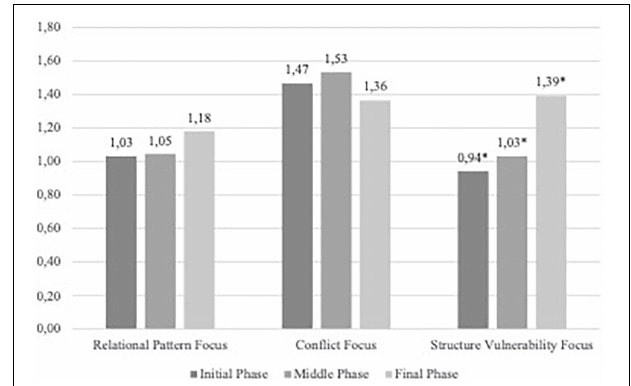
FIGURE 2 | Foci intensity in the three phases and the type of foci.